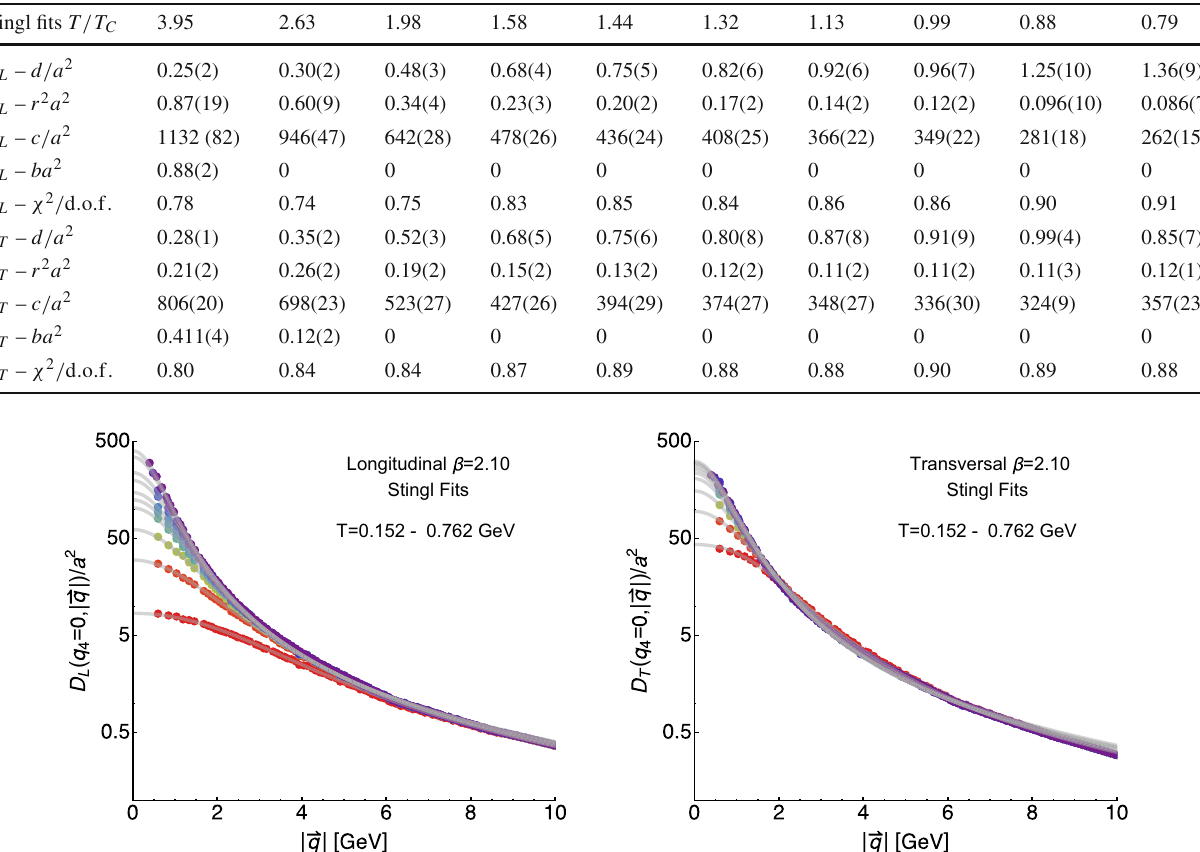
Table 3 Best fit parameters and their uncertainty for the Gribov–Stingl fits, applied to the longitudinal (top five rows) and the transversal (bottom five rows) correlator at β = 2 . 10